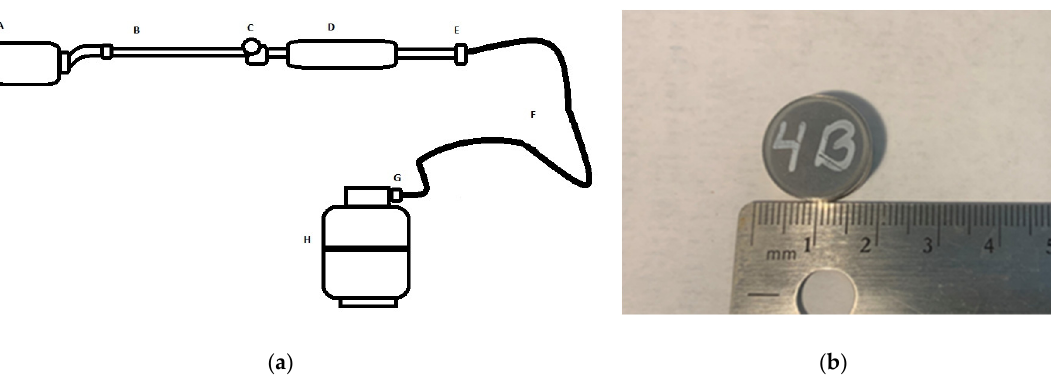
Figure 2. ( a ) A schematic of the propane torch, showing the torch head (A), neck tube (B), pilot valve (C), handle (D), hose connection (E), hose (F), pressure regulator (G), and propane tank (H). ( b ) An iButton temperature sensor. Sensors were buried in mineral soil below the litter/duff and programmed to log temperatures (Celsius) in 10-min intervals during the 40-day study period.